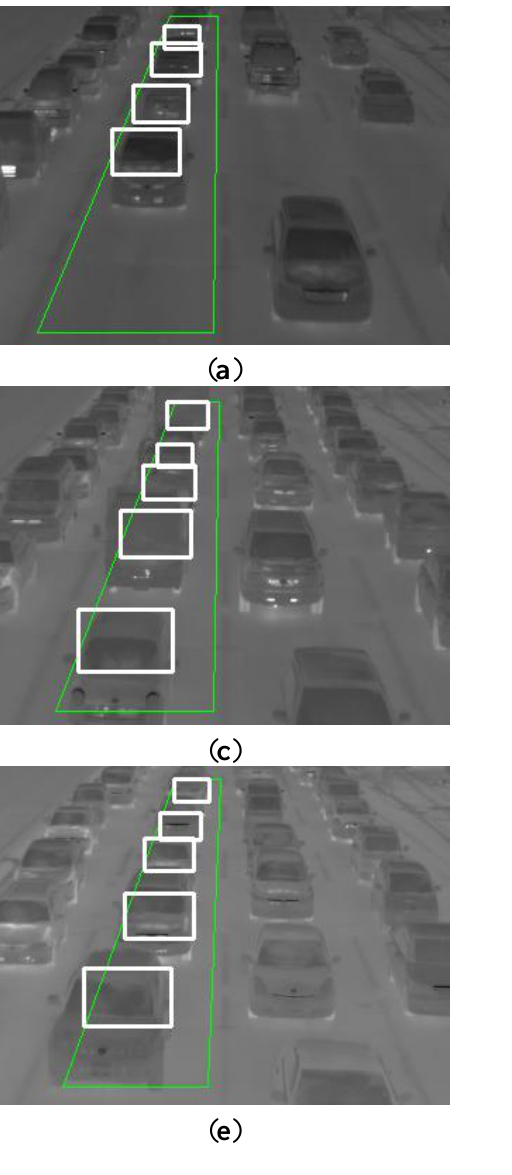
Figure 16. Some vehicle detection